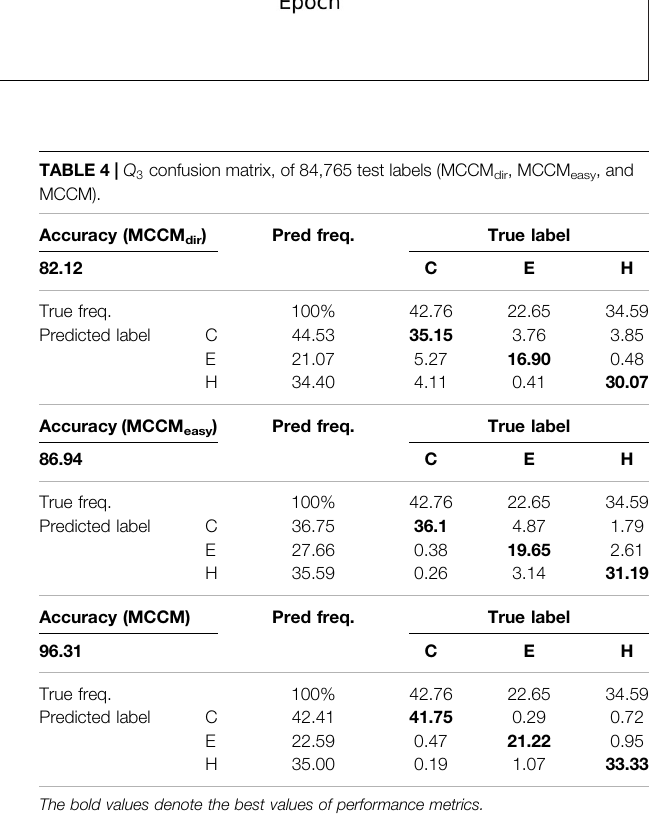
Figure 3 . Label-dependent MCCM and label-independent